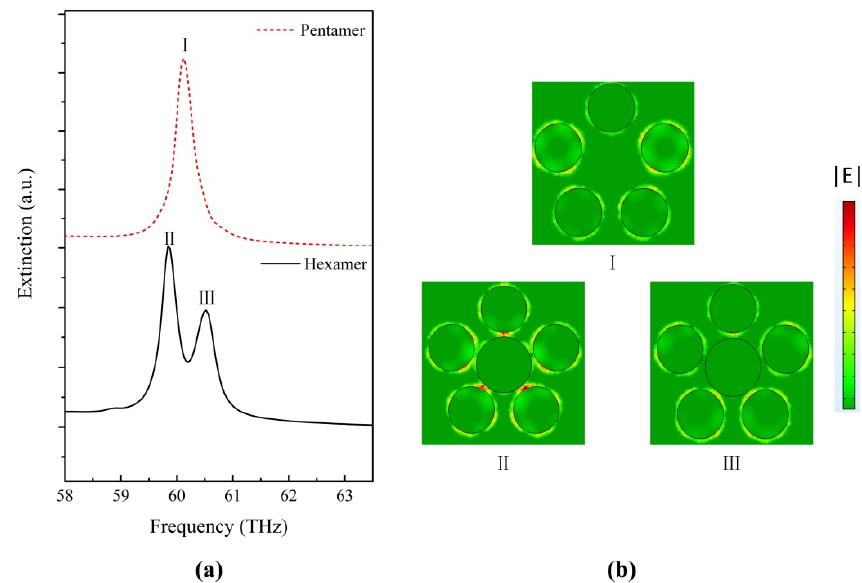
Figure 3. ( a ) Extinction spectra of graphene pentamer and graphene hexamer; ( b ) |E| distribution at the spectral peaks in Figure 3a. The Fano-like resonance is decomposed into two subgroups: the center and the ring.